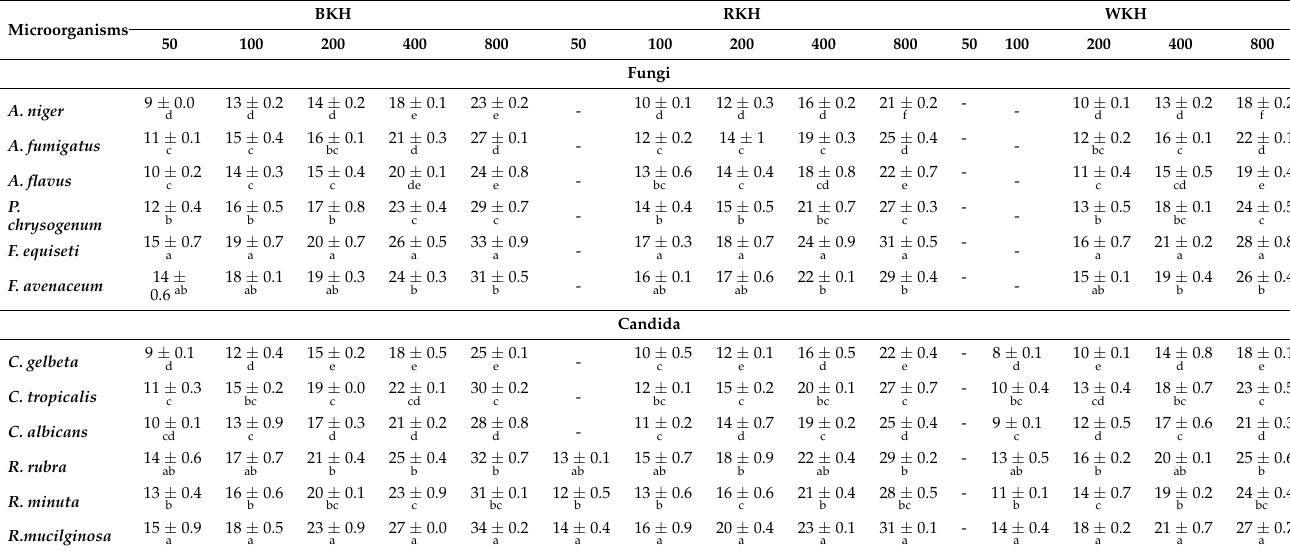
Table 5. Antifungal activity of black kidney, red and white bean protein hydrolysate (BKH, RKH, and WKH) obtained after 30 min Alcalase hydrolysis at 37 ◦ C, against yeast and fungal strains (means ± SD). Microorganisms